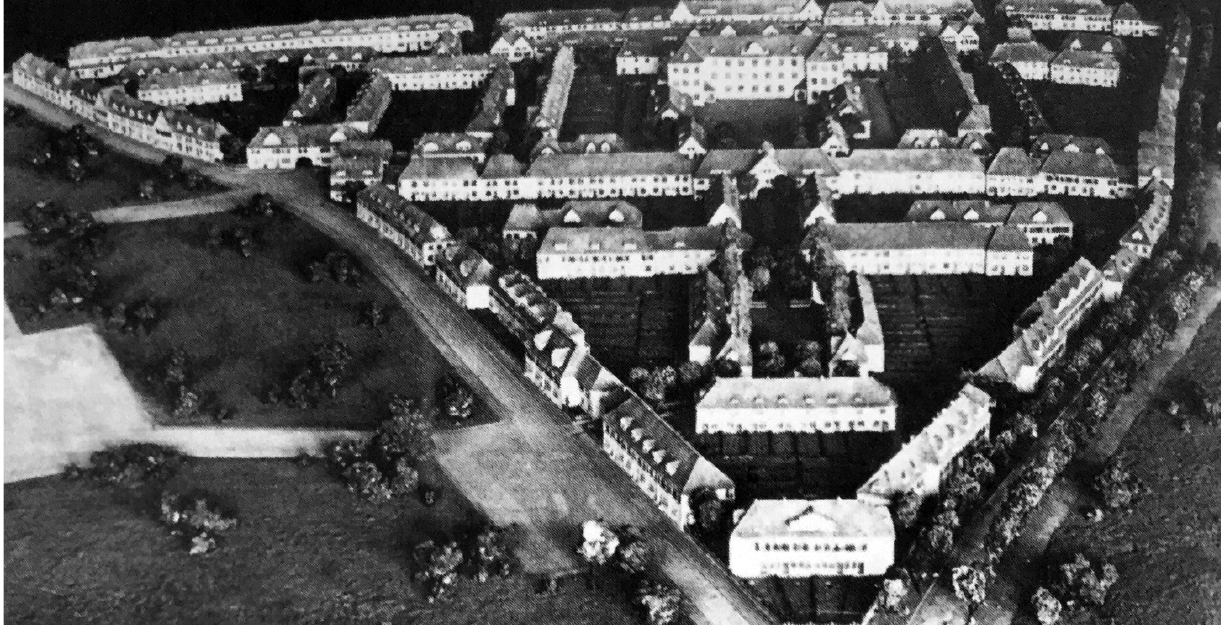
Figure 6. W. Riphahn and C. M. Grod, Bickendorf I. Architectural model for the 1914 competition. Source: Läuferts (2002).